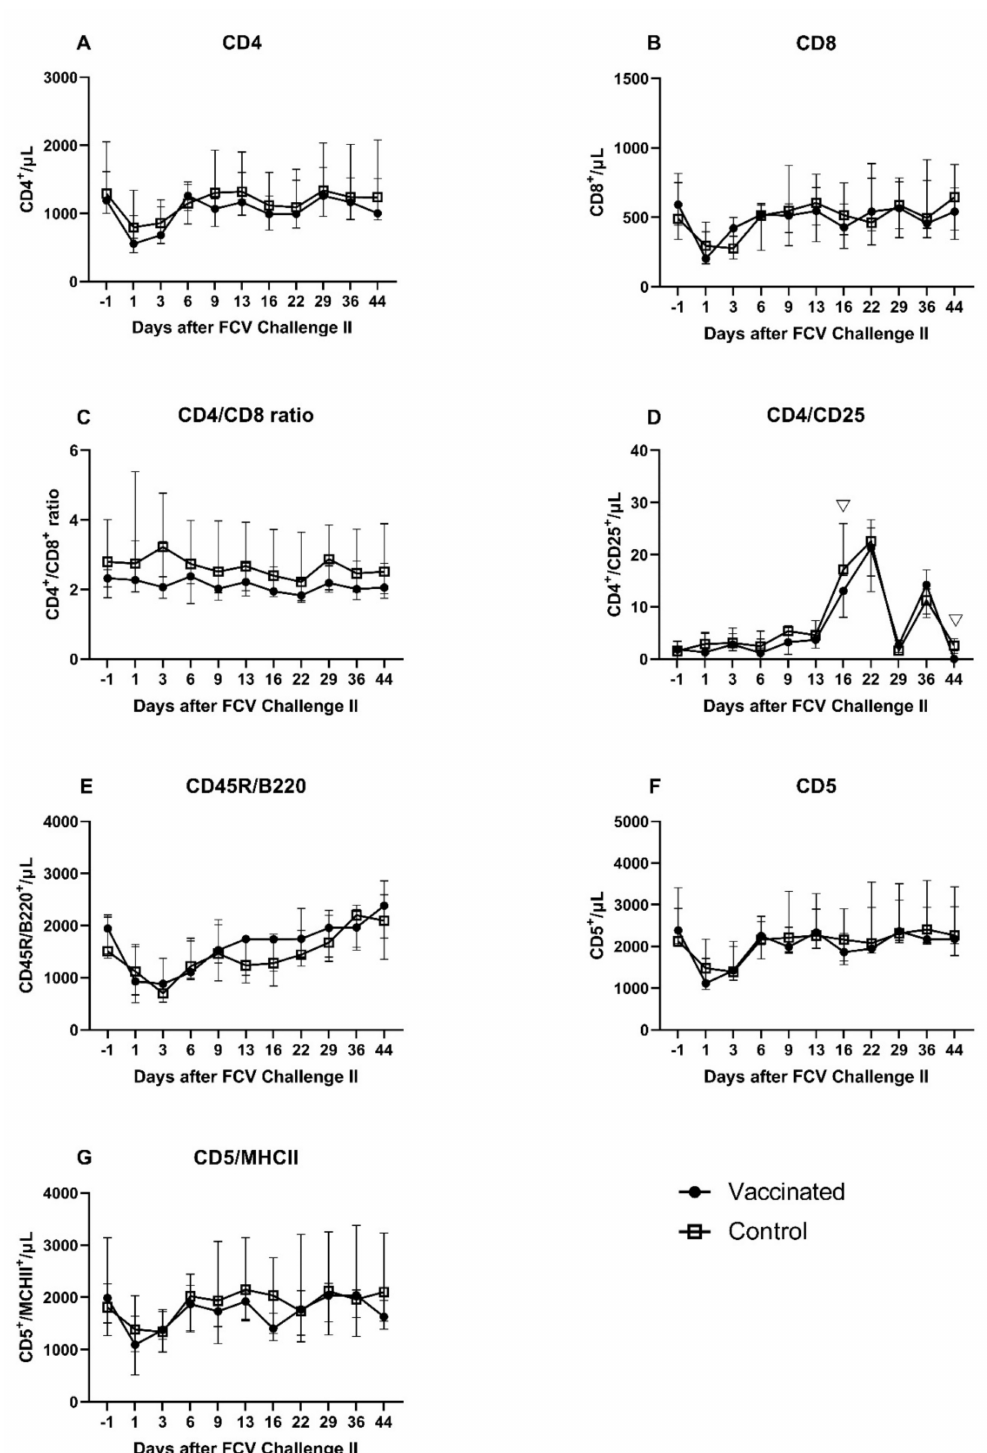
Figure 16. T- and B-lymphocyte subsets after FCV Challenge II. Median ( ± IQR) absolute cell counts of CD4 + ( A ), CD8 + ( B ), CD4 + /CD8 + ratio ( C ), CD4 + /CD25 + ( D ), B lymphocytes (CD45R/B220 + ) ( E ), CD5 + ( F ), and CD5 + /MHCII + ( G ) lymphocytes. Statistically significant differences between the vaccine and the control group are indicated with open triangles; (cid:53) denotes significantly lower in the vaccinated group P MWU ≤